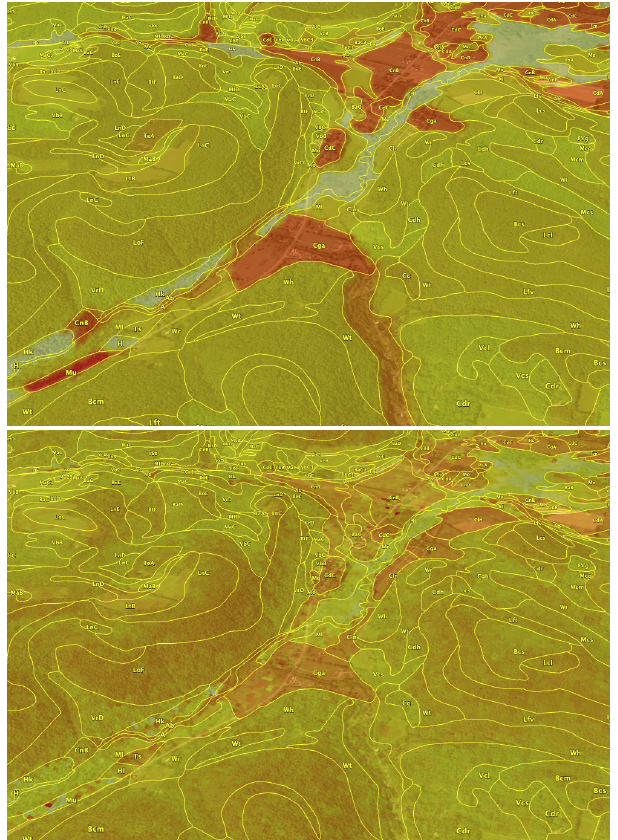
Figure 18. Ground overlay from gSSURGO (top) and PSP (bot- tom) for silt (%) at 0–5cm, with SSURGO polygons from SoilWeb. The centre of the image is at − 76 ◦ 16 (cid:48) 25 (cid:48)(cid:48) E, 42 ◦ 22 (cid:48) 53 (cid:48)(cid:48) N, with a view azimuth of 247 ◦ . Red colours are low silt, and in this window, alluvial fans (the C* map units) are shown. Pale grey colours are organic soils (the Hk and Hl map units). Light colours are high silt surface soils (the L* , V* , B* , and M* map units) from thin glacial till developed on shale and mudstone bedrock. gNATSGO polygons have only one value, and PSP disaggregates these, hence the pixe- lated pattern and somewhat smoothed boundaries. The background is from © Google Earth.